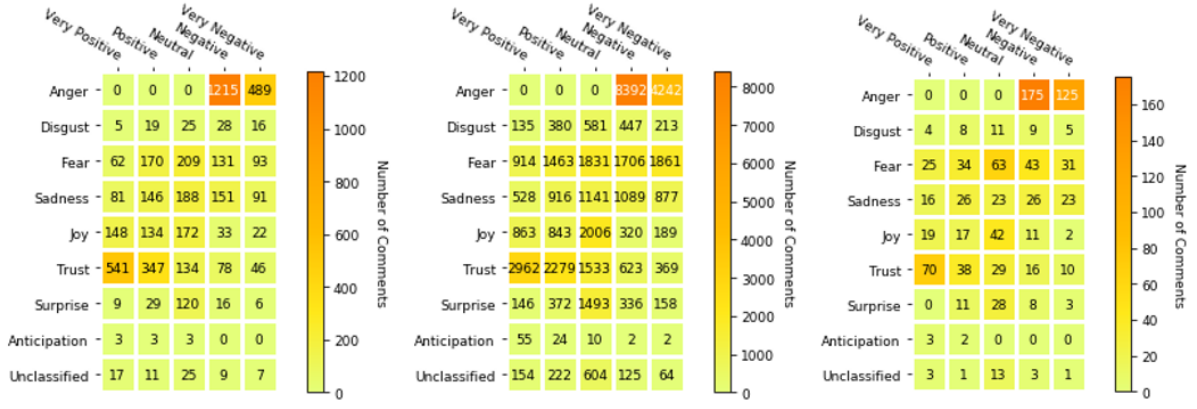
Figure 2. Sentiment and emotions heat map for coronavirus disease Facebook comments (left: Ministry of Health; middle: Centers for Disease Control and Prevention; right: Public Health England).